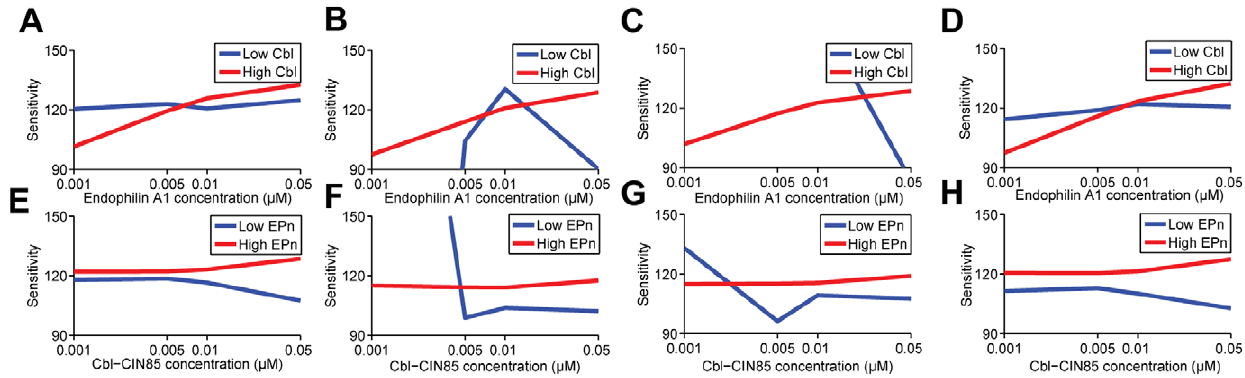
Figure 13. Detailed analysis on the sensitivities of EGFR endocytosis mediated by scaffold proteins KSR and MP1 coregulated by Cbl-CIN85 and Endophilin A1. Sensitivities of endocytosed EGFR toward EGF variation (A to D) regulated by Endophilin A1 concentration variation when Cbl-CIN85 is low (0.0001 m M) or high (0.8 m M); (E to H) Cbl-CIN85 concentration variation when Endophilin A1 is low (0.0001 m M) or high (0.8 m M) at four conditions: (A, E) when both scaffolds are present in suboptimal ‘‘low’’ levels [KSR =0.02 m M, MP1 =0.02 m M]; (B, F) when both scaffolds are present in optimally ‘‘high’’ concentrations as determined earlier [KSR =0.3 m M, MP1 =0.3 m M]; (C, G) when KSR is present at ‘‘high’’ level [0.3 m M] and MP1 at ‘‘low’’ level [0.02 m M]; (D, H) when MP1 is present at ‘‘high’’ level [0.3 m M] and KSR is at ‘‘low’’ level [0.02 m M].